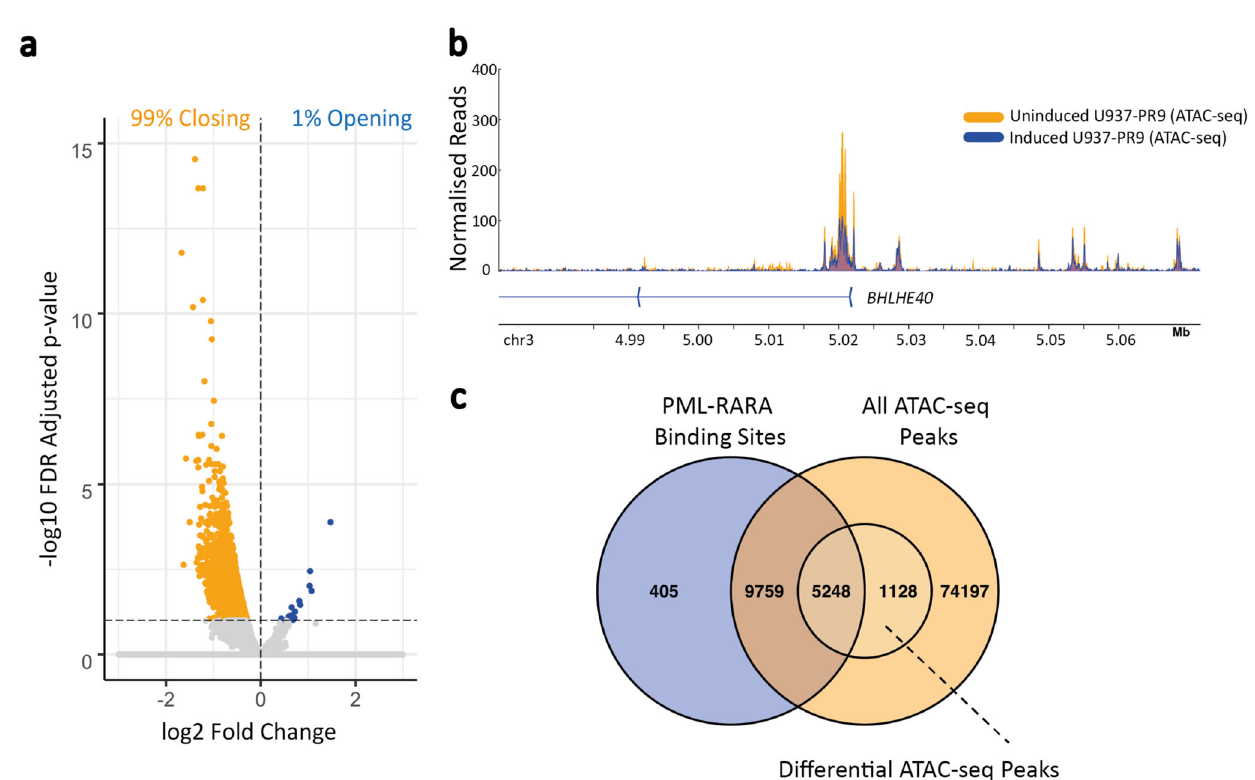
Fig. 4 | PML::RARA expression induces widespread reduction of open chro- matinregions.a VolcanoplotshowingthedifferentialATAC-seqpeakscomparing PML::RARA-induced cells to uninduced cells. Each dot represents an ATAC-seq peak. Peaks signi fi cantly reduced in size are colored orange and signi fi cantly increasing in size are blue. Signi fi cance threshold is adjusted p -value<=0.1. b Landscape plot showing an example of a differential ‘ closing ’ ATAC-seq peak at